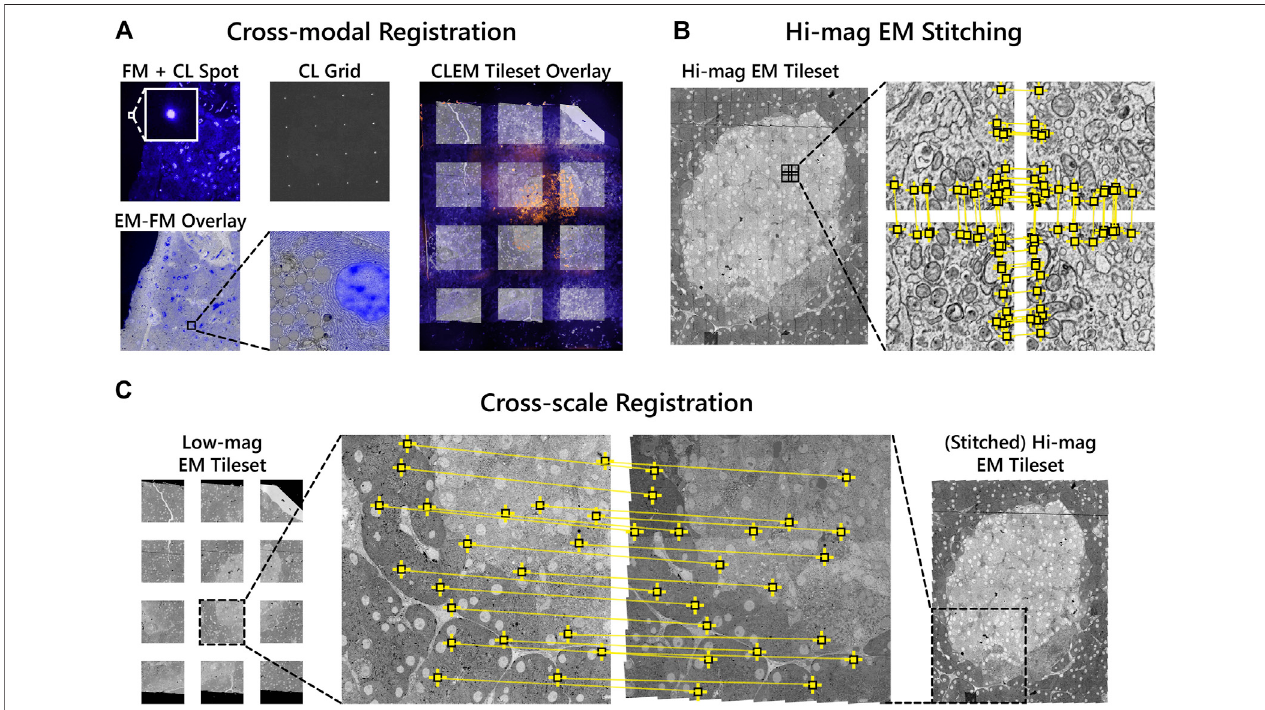
FIGURE 3 | Correlative alignment routine registers tilesets across modalities and scales. (A) Automated registration procedure for registering FM and low- magni fi cation EM image pairs using CL spots. FM tiles are then overlaid onto the low-magni fi cation EM tiles of each section. (B) SIFT features (yellow squares) are extractedandusedtostitchtogetherneighboringhigh-magni fi cationEMtileswithineachsection. (C) Low-magni fi cationEMimagesareregisteredtothecorresponding area of the stitched together high-magni fi cation EM tileset. The low-magni fi cation tiles thereby serve as a reference to ultimately overlay the fl uorescence onto the high-magni fi cation